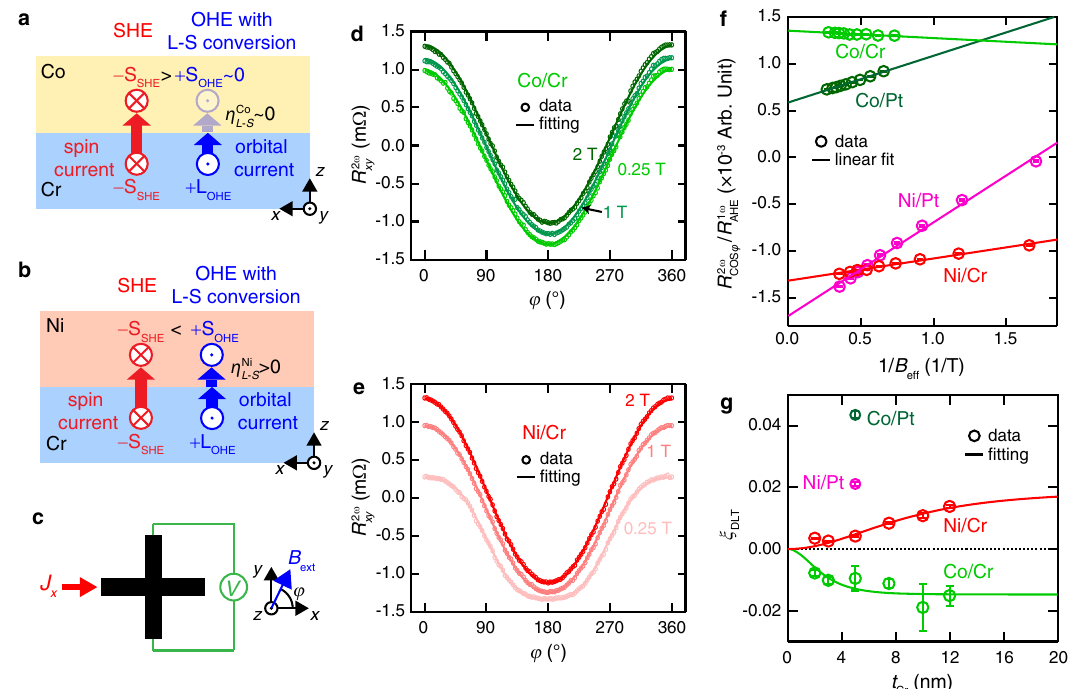
Fig. 1 Orbital – current-induced spin torque in Cr/ferromagnet heterostructures. a , b Schematic illustrations of the angular momentum transfer by spin current (red arrows) and orbital current (blue arrows) for Co ( a ) and Ni ( b ) ferromagnets (FMs). The spin (orbital) angular momentum is represented by S ( L ). The source of S and L is marked by the subscript of SHE (OHE) for spin Hall effect (orbital Hall effect). η Co ð Ni Þ L is the orbital-to-spin conversion ef fi ciency (cid:2) S of Co (Ni). c The R 2 ω xy ð φ Þ measurement geometry for a Hall-bar sample. φ is the azimuthal angle of the external magnetic fi eld ( B ext ) with respect to the current direction. d , e Azimuthal angle ( φ ) dependent second harmonic Hall resistance, R 2 ω xy ð φ Þ , under different B ext of Co (3.0 nm)/Cr (7.5 nm) ( d ) and Ni (2.0 nm)/Cr (7.5 nm) ( e ) samples. The solid lines are the fi tting curves using Eq. (2). Each R 2 ω xy ð φ Þ curve of Co/Cr ( d ) and Ni/Cr ( e ) is shifted by a y -axis = R 1 ω offset to clearly show the B ext dependence. f R 2 ω as function of 1/ B eff of Ni/Cr (red), Co/Cr (light-green), Ni/Pt (magenta), and Co/Pt (green) COS φ AHE samples. Each solid line is the linear fi tting line. The error bars in f are due to the standard deviation of the fi tting of the R 2 ω xy ð φ Þ versus φ curves using Eq. (2), which are smaller than the symbol size. g Cr thickness ( t Cr ) dependent damping-like torque ef fi ciency ( ξ DLT ) of Ni/Cr (red) and Co/Cr (light-green) samples, where t Cr ranges from 2 to 12.5 nm. The fi tting results of orbital and spin diffusion lengths for Ni/Cr and Co/Cr are given in solid curves. The ξ ’ s of the reference Ni/Pt (magenta) and Co/Pt (green) samples are included for comparison. Lines are guides to eyes. All measurements are DLT conducted at 300 K. The error bars in g are due to the standard deviation of the linear fi tting of the cos φ components of Eq. (2) versus 1/ B eff